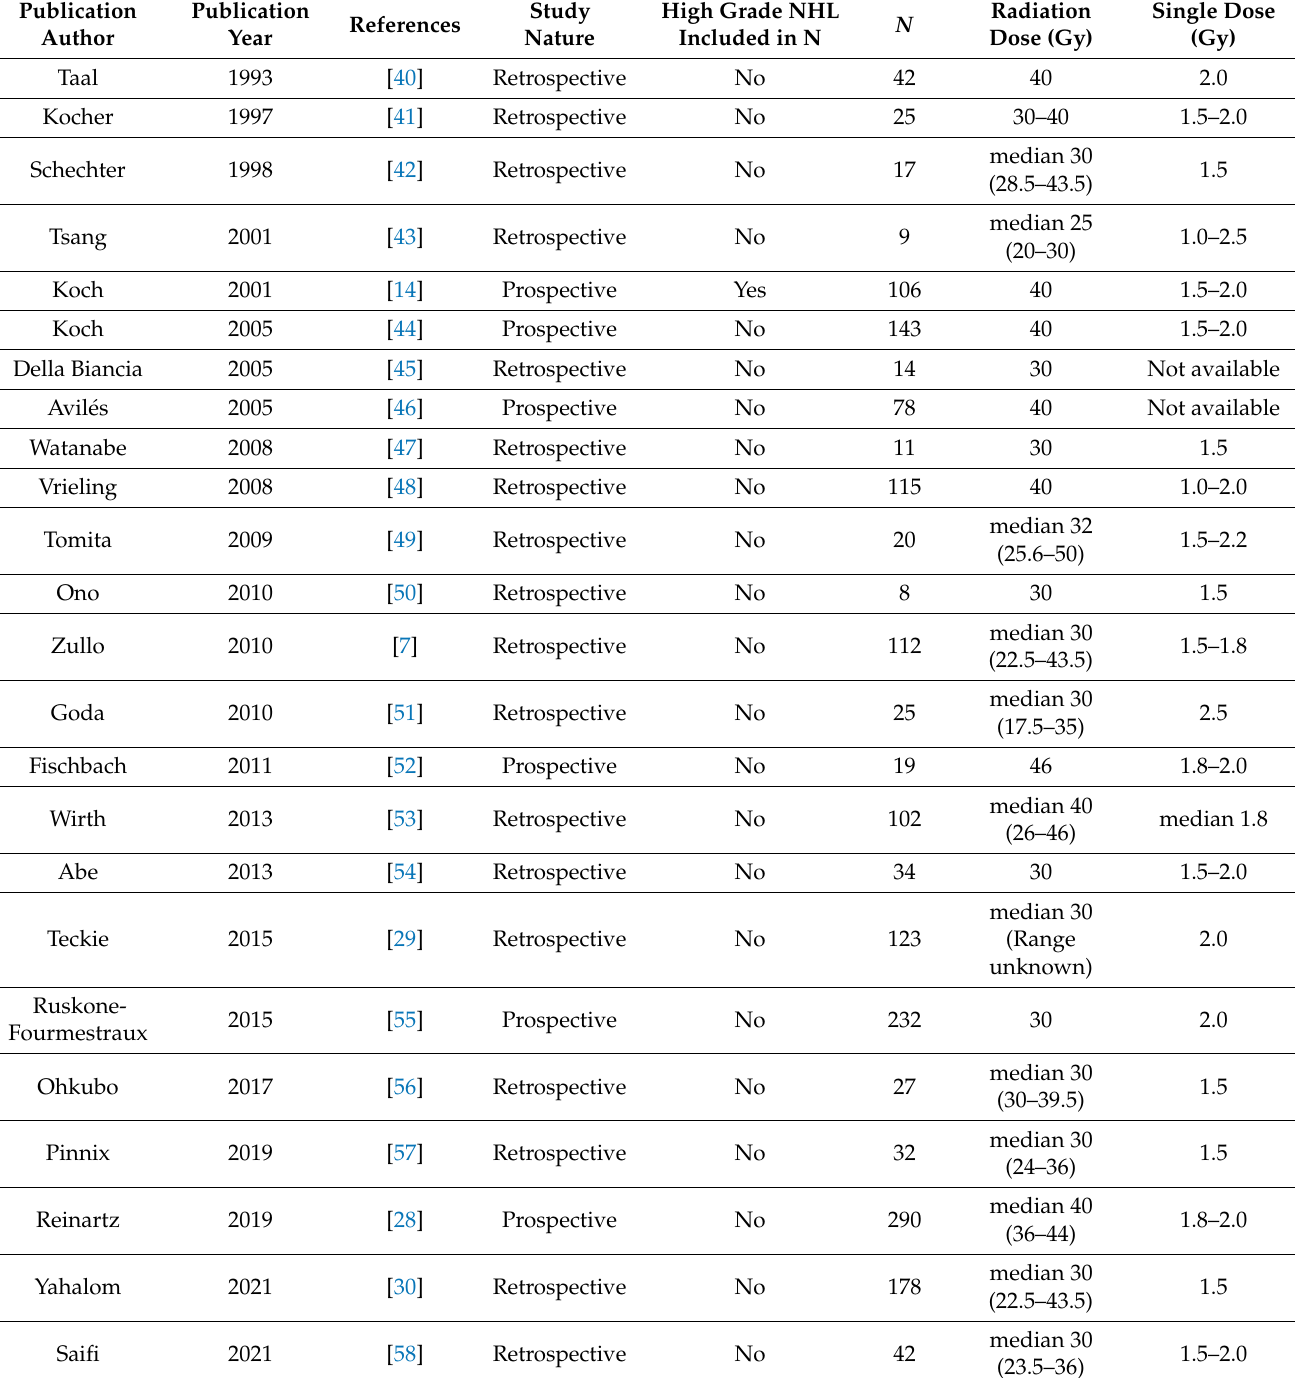
Table 1. The development of total radiation doses for the treatment of gMZL from the 1990s to the present